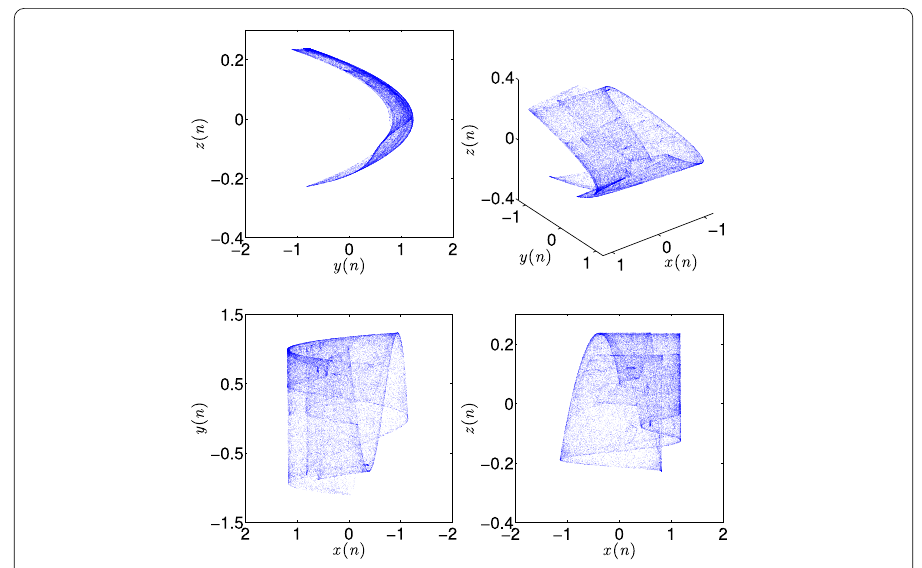
Figure 1 Phase portraits of the classical Stefanski